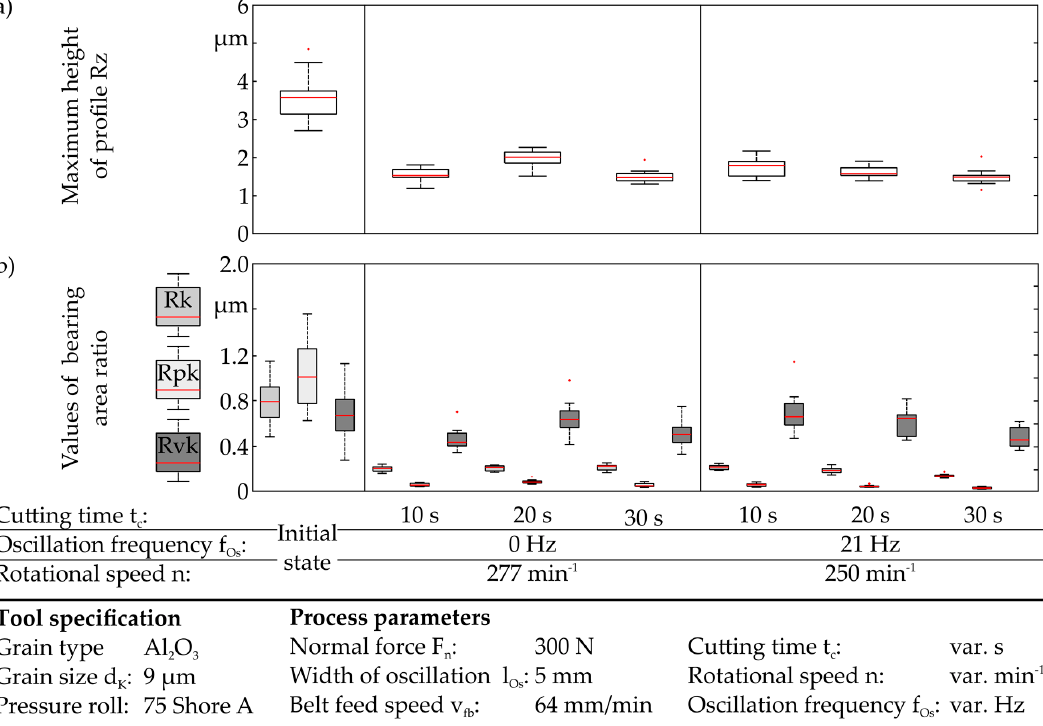
Figure 7. Surface parameters of the initially structured surface and the subsequently microfinished surface using the grain size d K = 9 µm. ( a ) Rz; ( b ) Rk, Rpk, and Rvk. surface using the grain size d µ m. ( a ) Rz; ( b ) Rk, Rpk, and K = 9